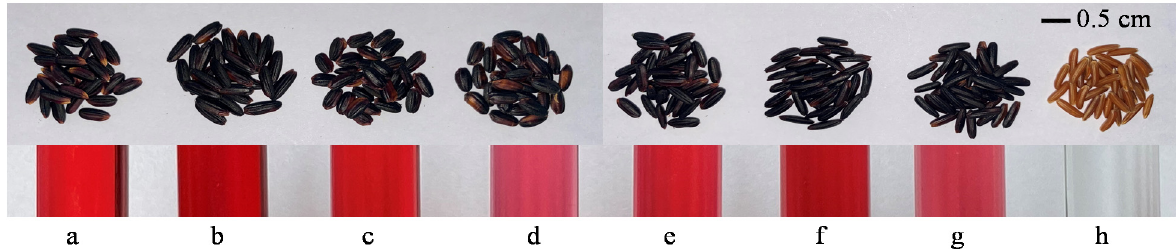
Figure 3. Examples of Thai purple rice varieties rich in anthocyanins. ( a ) Kum Doi Saket, ( b ) Kum Akha ( c ) Pieisu ( d ) Kum Hom CMU, ( e ) KJ CMU 107, ( f ) Riceberry, ( g ) Hom Nil, ( h ) Sang Yod.